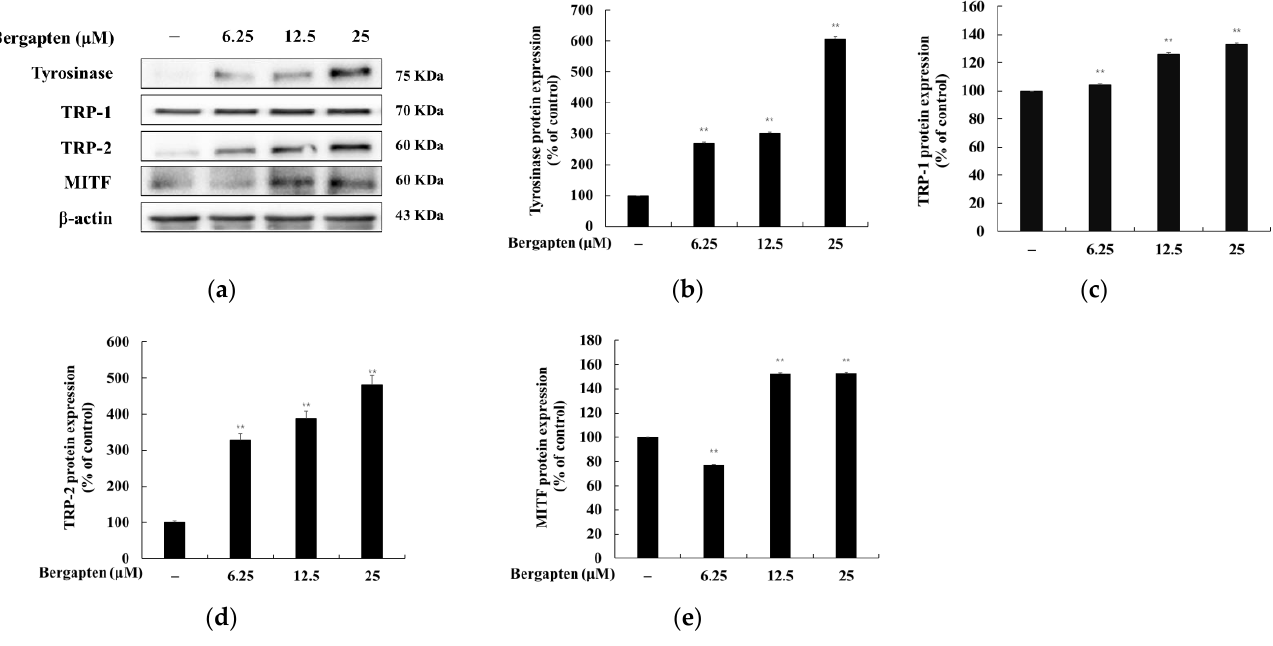
Figure 5. Effects of bergapten on the protein expression level of tyrosinase, TRP-1, TRP-2, and MITF in B16F10 melanoma cells. The cells were treated with bergapten (6.25, 12.5, and 25 µ M) for 48 h. ( a ) Western blotting results and protein expression of ( b ) tyrosinase, ( c ) TRP-1, ( d ) TRP-2, and ( e ) MITF. β -actin was used as a loading control. The results are presented as the mean ± SD of three independent measurements using Image J. ** p < 0.01 vs. untreated group.